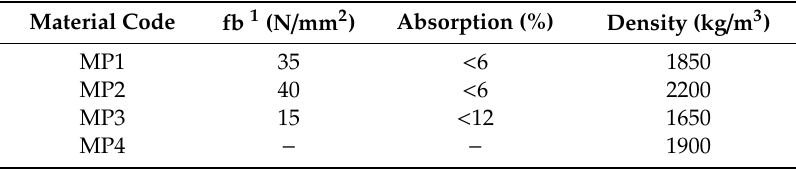
Table 1. Properties of the four masonry materials studied in this project.